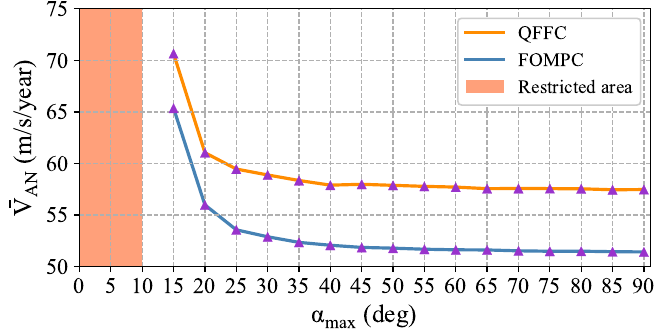
Figure 11. The results of Monte Carlo simulations for α max .